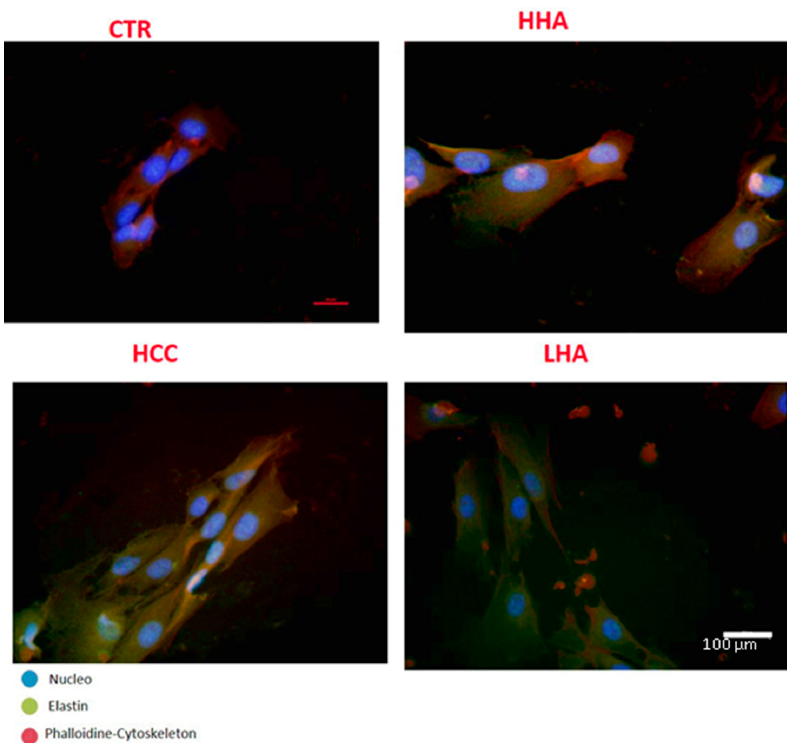
Figure 2. Expression of elastin in HaCaT/HDF co-cultures for a control and in the presence of HHA, LHA, and HCC. Images were taken after 24 h of treatment. The panels show triple immunofluorescence analysis for cytoskeleton (red), nucleus (blue), and elastin (green). In the presence of HCC, the expression of elastin was increased. Scale bar represents 100 µ m.